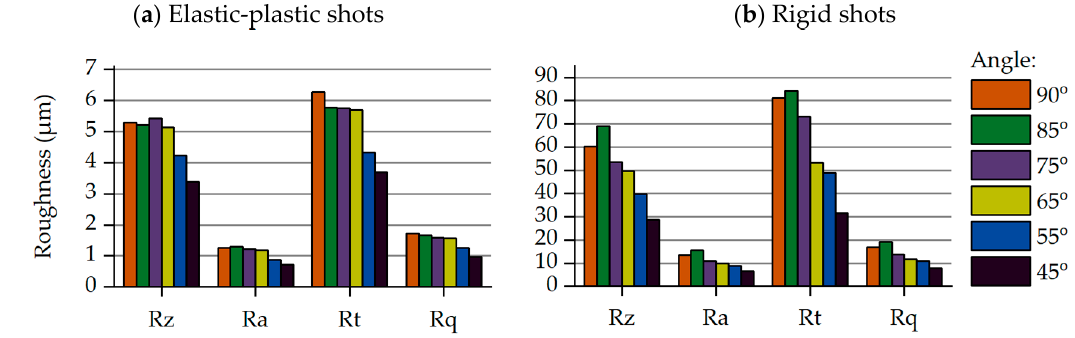
Figure 7. Roughness values for variable impact angle: elastic-plastic and rigid shots approximation. ( a ) Elastic-plastic shots; ( b ) Rigid shots.